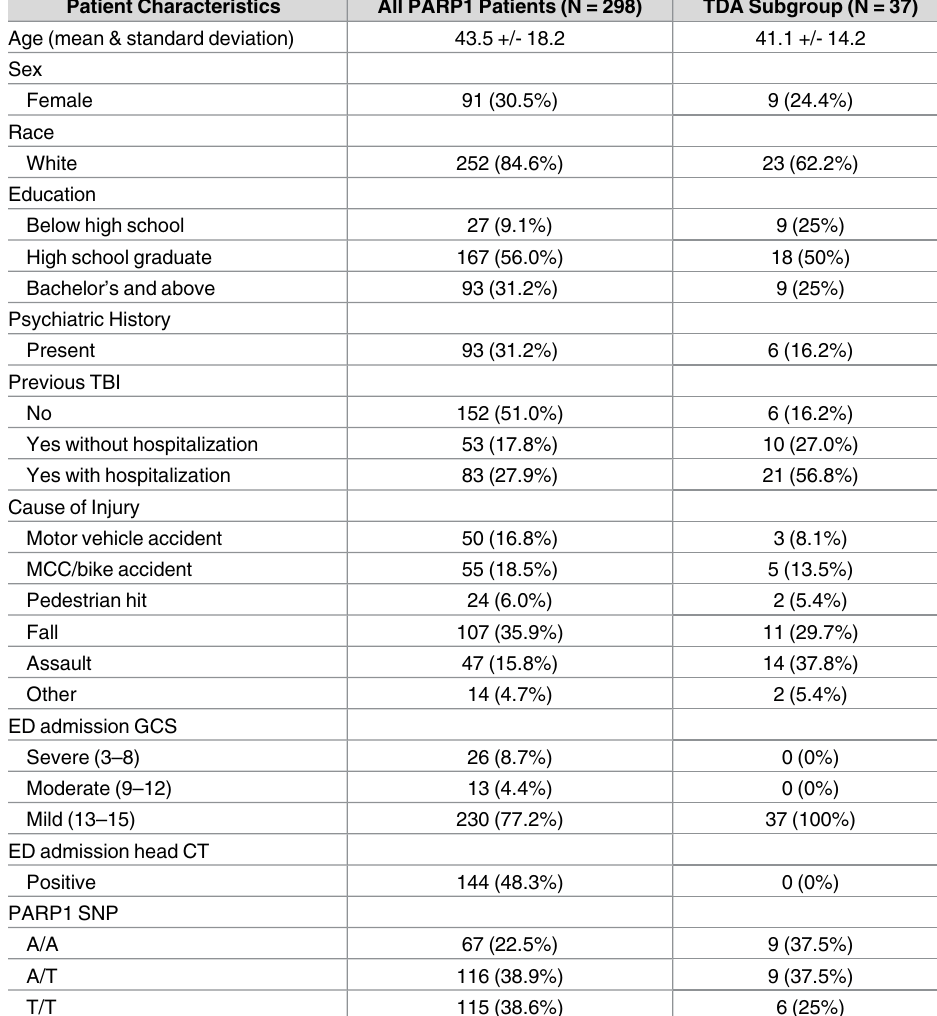
Table 5. Clinical characteristics of TDA-identified patient subgroup with PARP1 SNP (N = 37) along- side to all patients with PARP1 SNP (N =